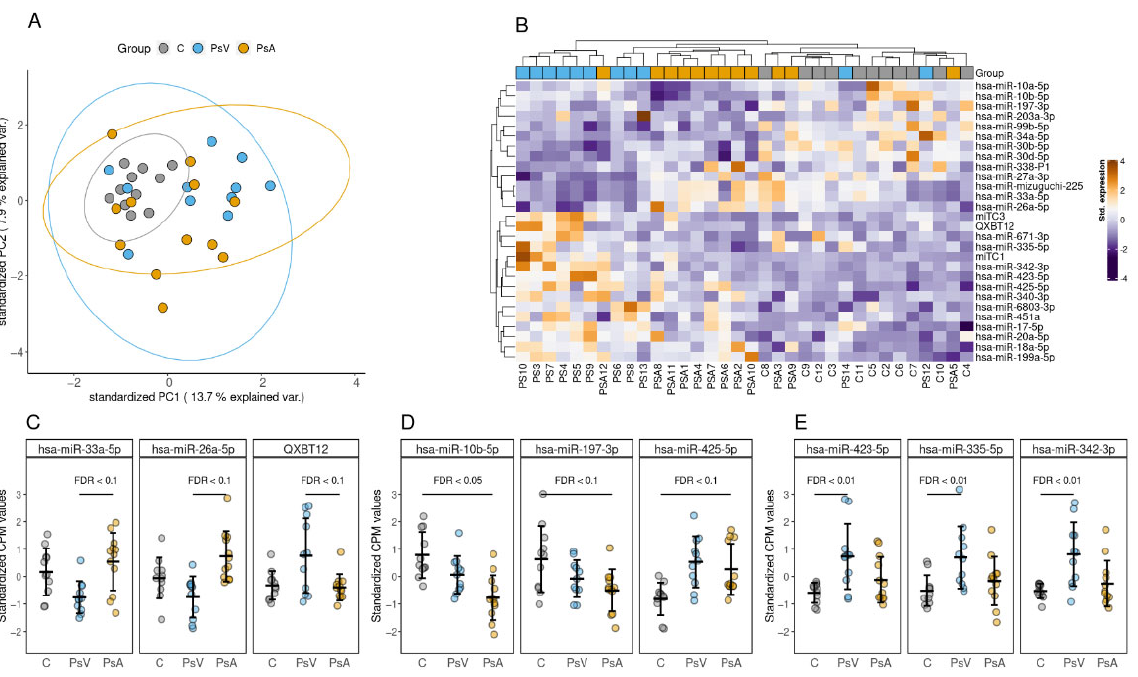
Figure 3. miRNA profile for blood serum EV samples. ( A ) The first two principal components calcu- lated based on 212 miRNAs considered to be uniformly detected in at least one of the patient groups. Ellipses represent 95% confidence intervals. ( B ) Heatmap and hierarchical clustering (Manhattan dis- tance) of miRNAs with an FDR value ≤ 0.1 resulting from any of the pairwise comparisons between the patient groups. ( C ) Top three miRNAs differentially enriched in EV samples isolated from the blood serum of noninflammatory control patients compared to patients with PsV and psoriatic arthri- tis (PsA). The miRNA abundance is presented as standardized (z-score) counts per million (CPM) values. ( D ) Top three miRNAs differentially enriched EV samples isolated from the blood serum of PSA patients and noninflammatory controls ( C ). ( E ) Top three miRNAs differentially enriched EV samples isolated from the blood serum of PsV patients and noninflammatory controls ( C ).